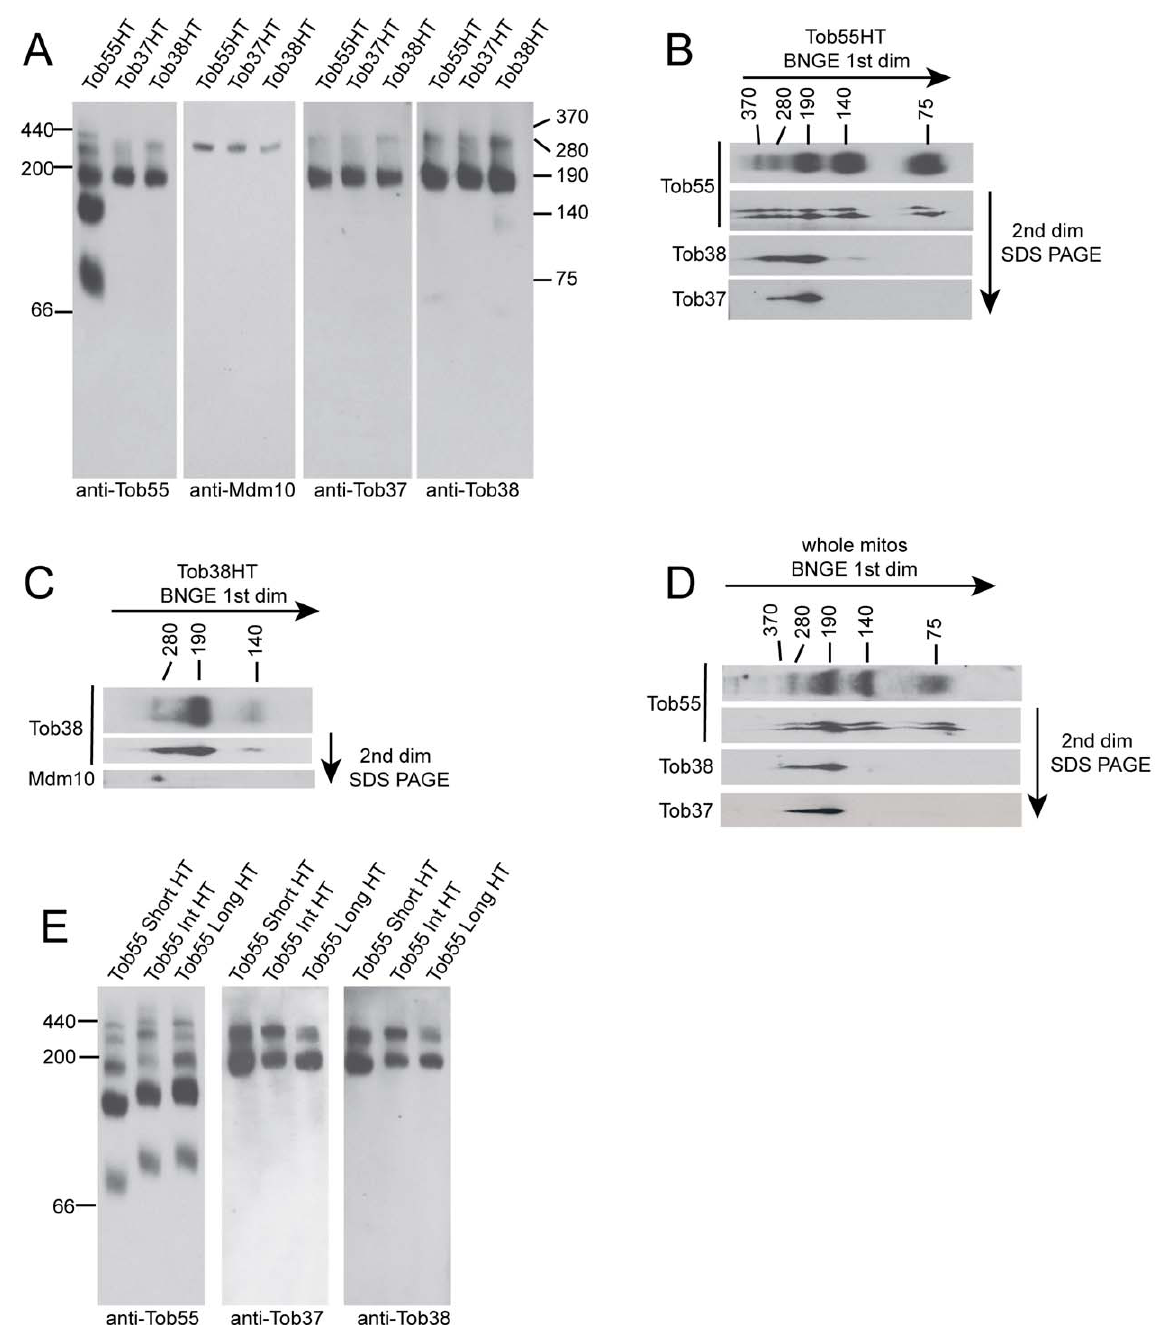
Figure 3. The N.crassa TOB complex. (a) Number and protein content of N. crassa TOB complexes. Mitochondria were isolated from strains expressing only His-tagged versions (instead of the endogenous versions) of either Tob55 (Tob55HT), Tob38 (Tob38HT), or Tob37 (Tob37HT) as indicated for each lane at the top of the panel. TOB complexes were purified using Ni-NTA resin. Purified complexes were subjected to BNGE, transferred to PVDF membrane, and decorated with antibodies to Tob55, Mdm10, Tob37, or Tob38 as indicated at the bottom of each panel. The position of molecular weight markers (kDa) is shown on the left and the estimated size (kDa) of complexes is shown on the right. (b) TOB complex was purified from a strain carrying His-tagged Tob55 and subjected to first dimension BNGE (1 st dim) in two separate lanes of the gel. One lane was transferred to PVDF, and decorated with antibody to Tob55 (top lane in panel). The second lane was removed for second dimension (2 nd dim) electrophoresis by SDS-PAGE as described in the Methods. Following SDS-PAGE, the gel was transferred to nitrocellulose. The membrane was cut into strips corresponding to the molecular weights of Tob55, Tob38, and Tob37 and probed with antibodies to those proteins, respectively (indicated on the left). Sizes of TOB complex following 1 st dimension BNGE are indicated at the top of the panel. (c) As in panel B, except the purification was performed using mitochondria containing His-tagged Tob38 and the SDS-PAGE blot was examined with antibodies to Tob38 and Mdm10. (d) As in panel B except that whole mitochondria were examined for the presence of TOB complexes. (e) As in panel A, except TOB complex was purified from mitochondria isolated from cells expressing only His-tagged versions of different Tob55 isoforms [27]: short Tob55 (Tob55 Short HT), intermediate Tob55 (Tob55 Int HT), or long Tob55 (Tob55 Long HT) as indicated at the top of the panels. Blots were immunodecorated with the antibodies indicated at the bottom of the panels.